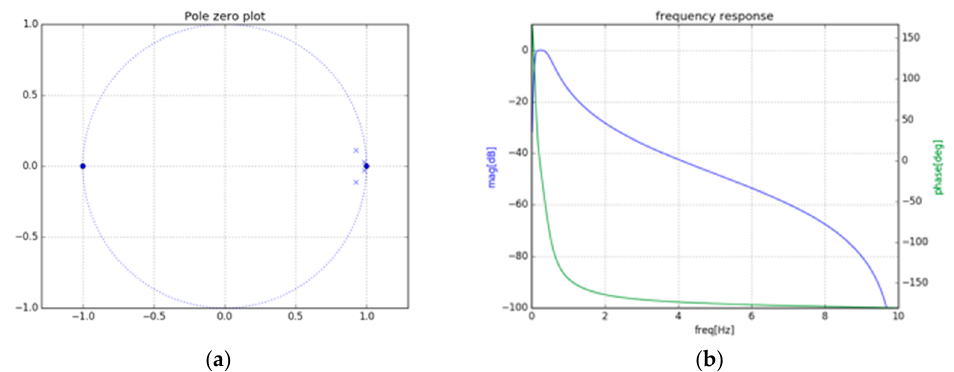
Figure 5. ( a ) Pole-zero plot, and ( b ) frequency response for fourth-order IIR cascaded Bi-quad BPF.